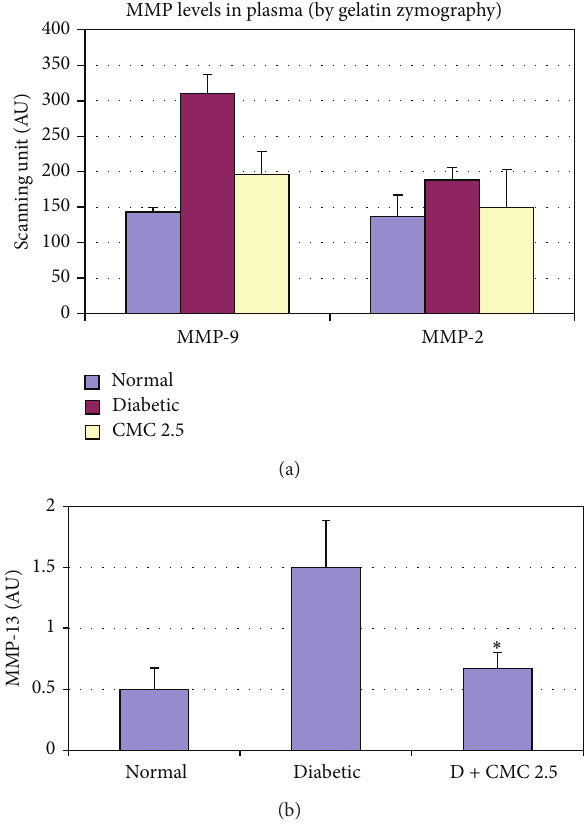
Figure 7: The effect of diabetes and orally administered CMC 2.5 on plasma MMPs. Male Sprague-Dawley rats ( 𝑛 = 6 ) were injected i.v. with streptozotocin (STZ) 70 mg/kg to induce diabetes, as described by us previously. STZ-diabetic rats were daily administered by oral gavage CMC 2.5 (100mg/kg) for 3 weeks. At the end of the treatment protocol, rats were sacrificed by exsanguination; blood samples were collected and analyzed for MMP-9 by gelatin zymography and MMP-13 by Western blot, and were scanned densitometrically to quantify the levels of MMP-9 and MMP-13. ∗ 𝑃 < 0.05